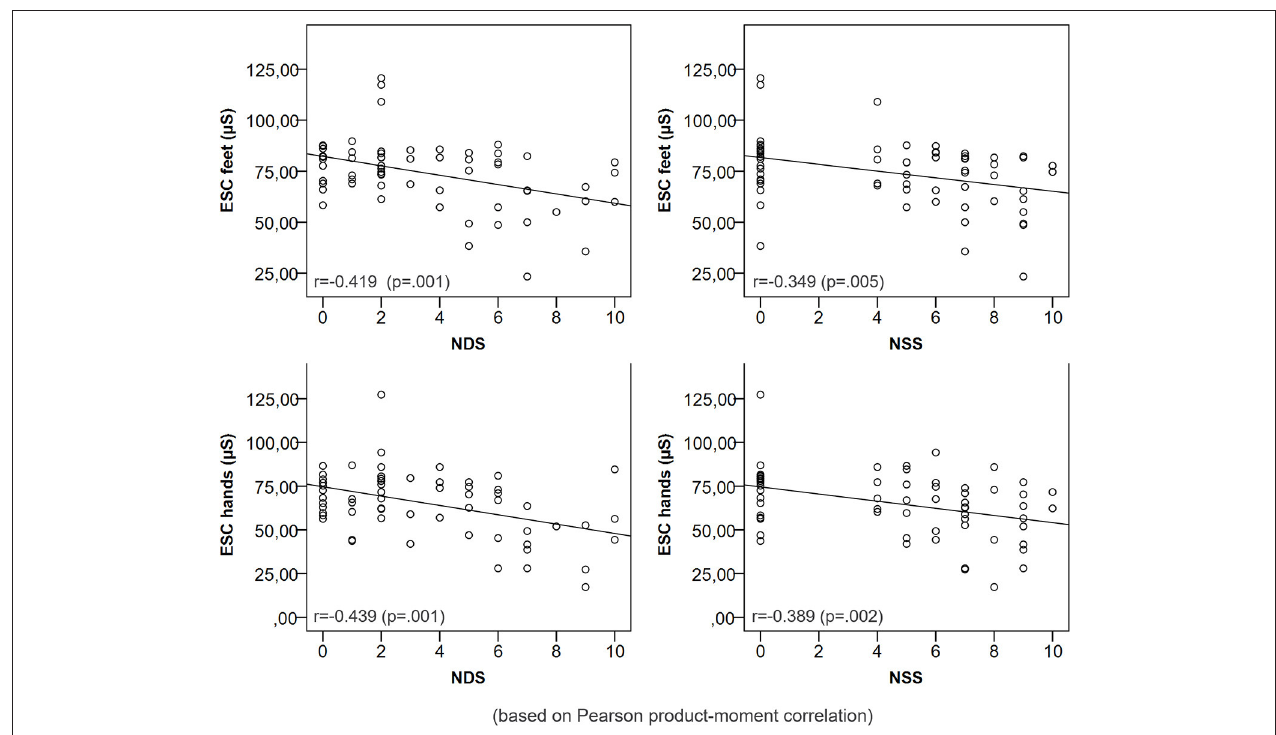
FIGURE 2 | Correlation of ESC with NDS/NSS.